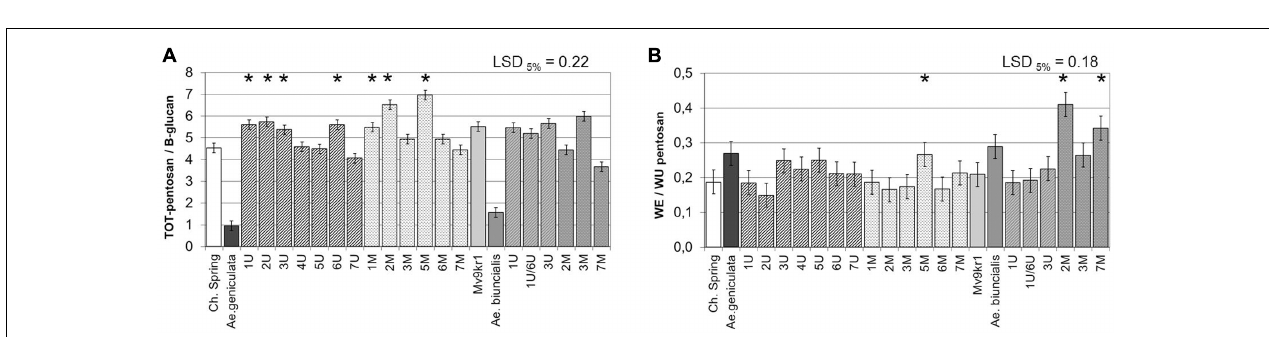
FIGURE 3 | Compositional properties of mature grains of two lines of bread wheat (cv. Chinese Spring and Mv9kr1 line), two Aegilops species ( Ae. geniculata and Ae. biuncialis ), and wheat– Aegilops chromosome addition lines. (A) β -Glucan, (B) TOT-pentosan, and (C) WE-pentosan content. LSD, least significant difference; TOT, total; WE, water-extractable. ∗ Significantly higher than the wheat ( T. aestivum ) control.